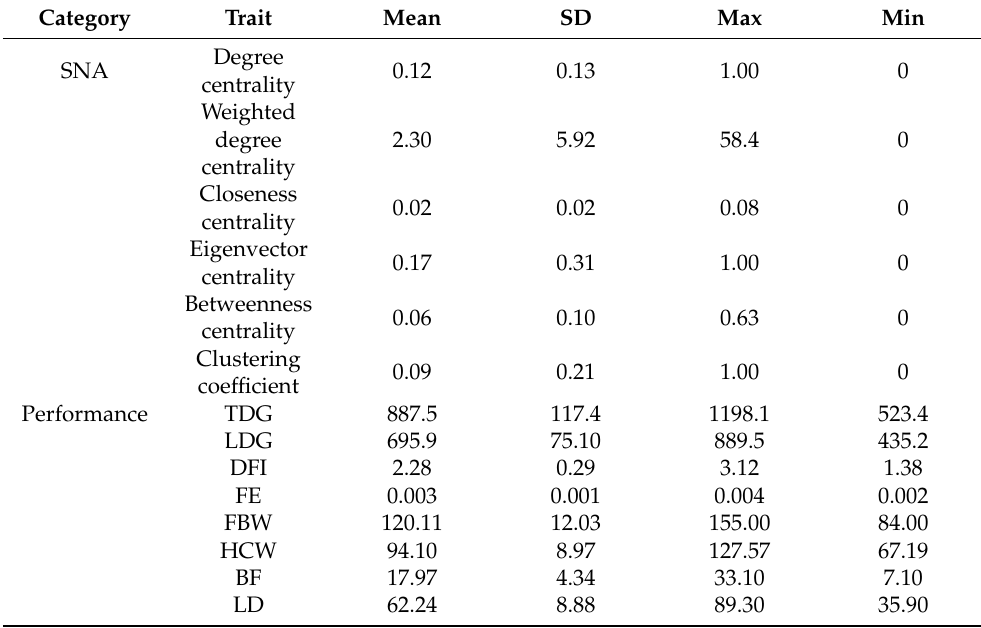
Table 2. Descriptive statistics of the transformed SNA traits and performance